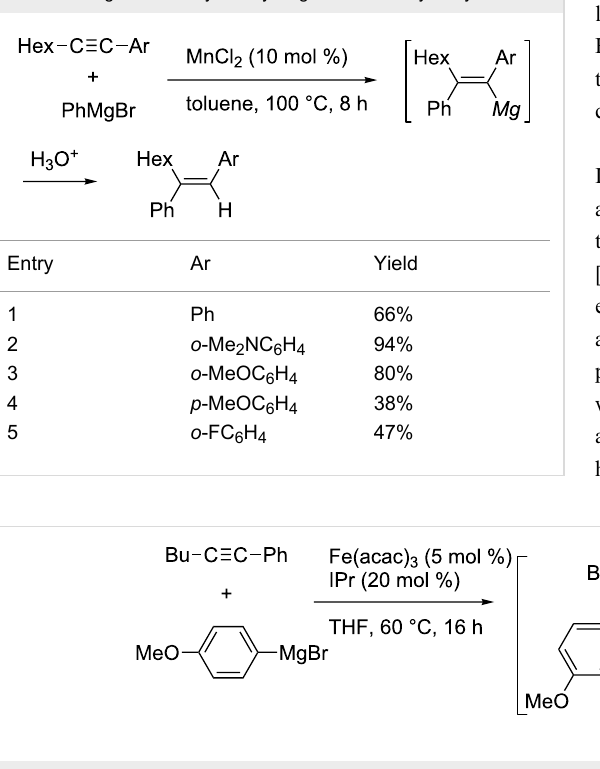
Table 4: Manganese-catalyzed arylmagnesiation of